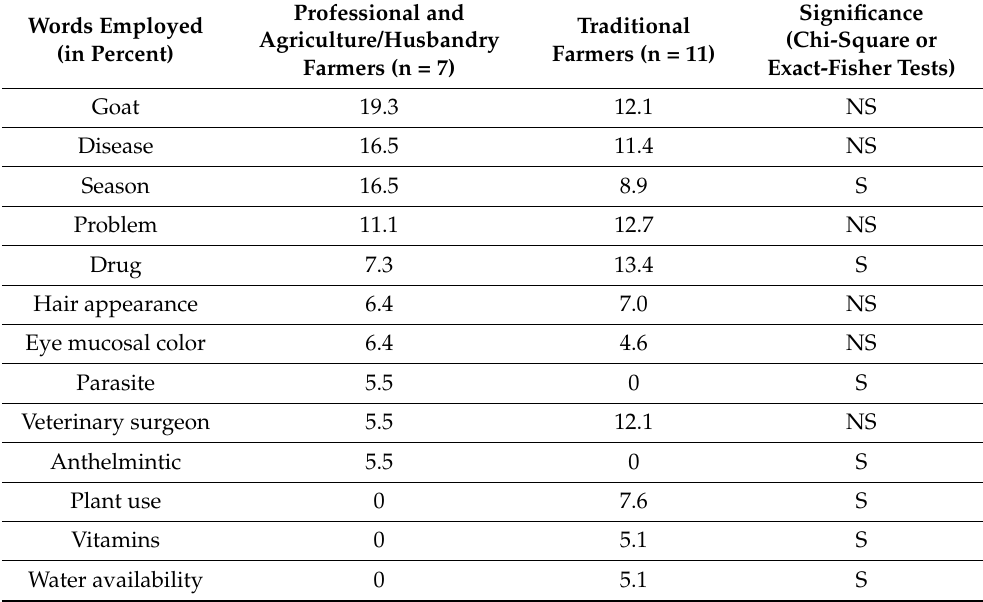
Table 3. The percent occurrence of words used by different categories of farmers.